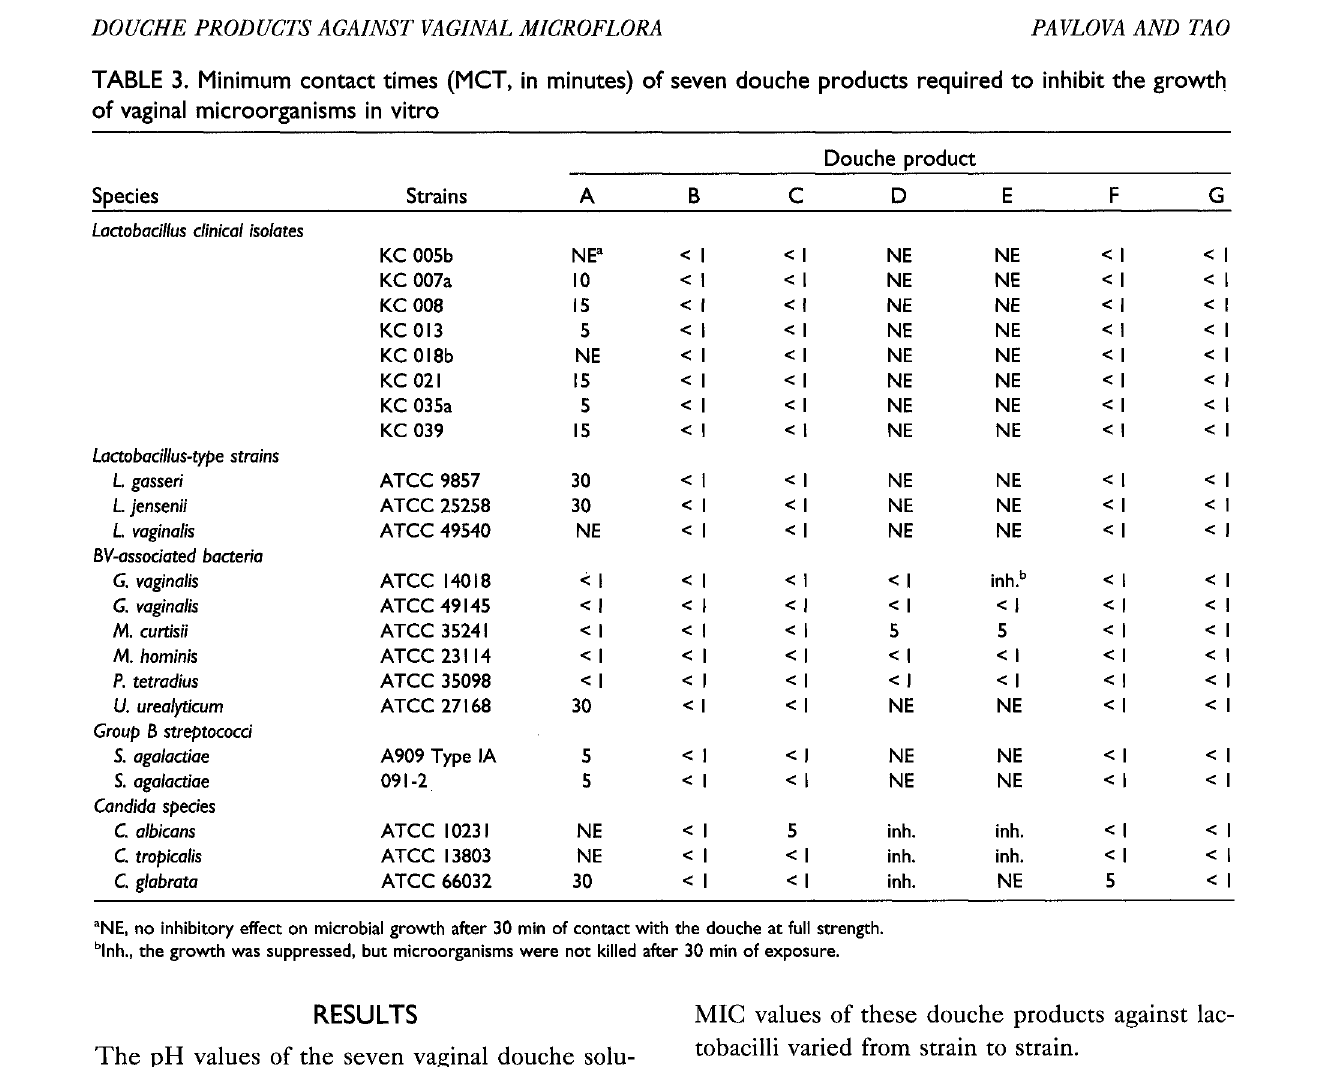
TABLE 3. Minimum contact times (MCT, in minutes) of seven douche products required to inhibit the growth of vaginal microorganisms in vitro Species Strains Lactobacillus clinical